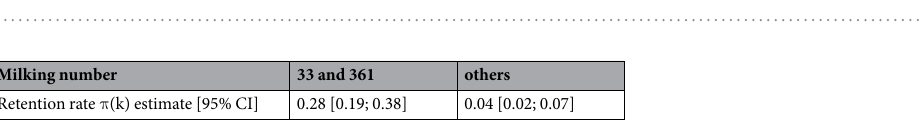
Table 4. Estimation of the conditional elements β in the milking-session model.